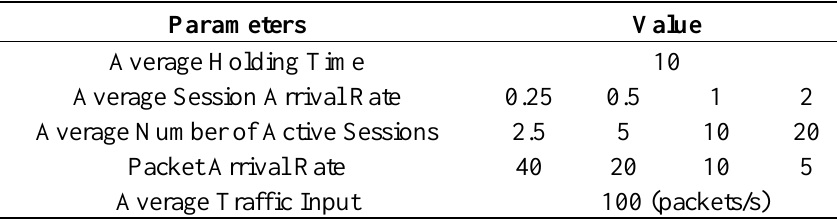
Table 5. Experimental session